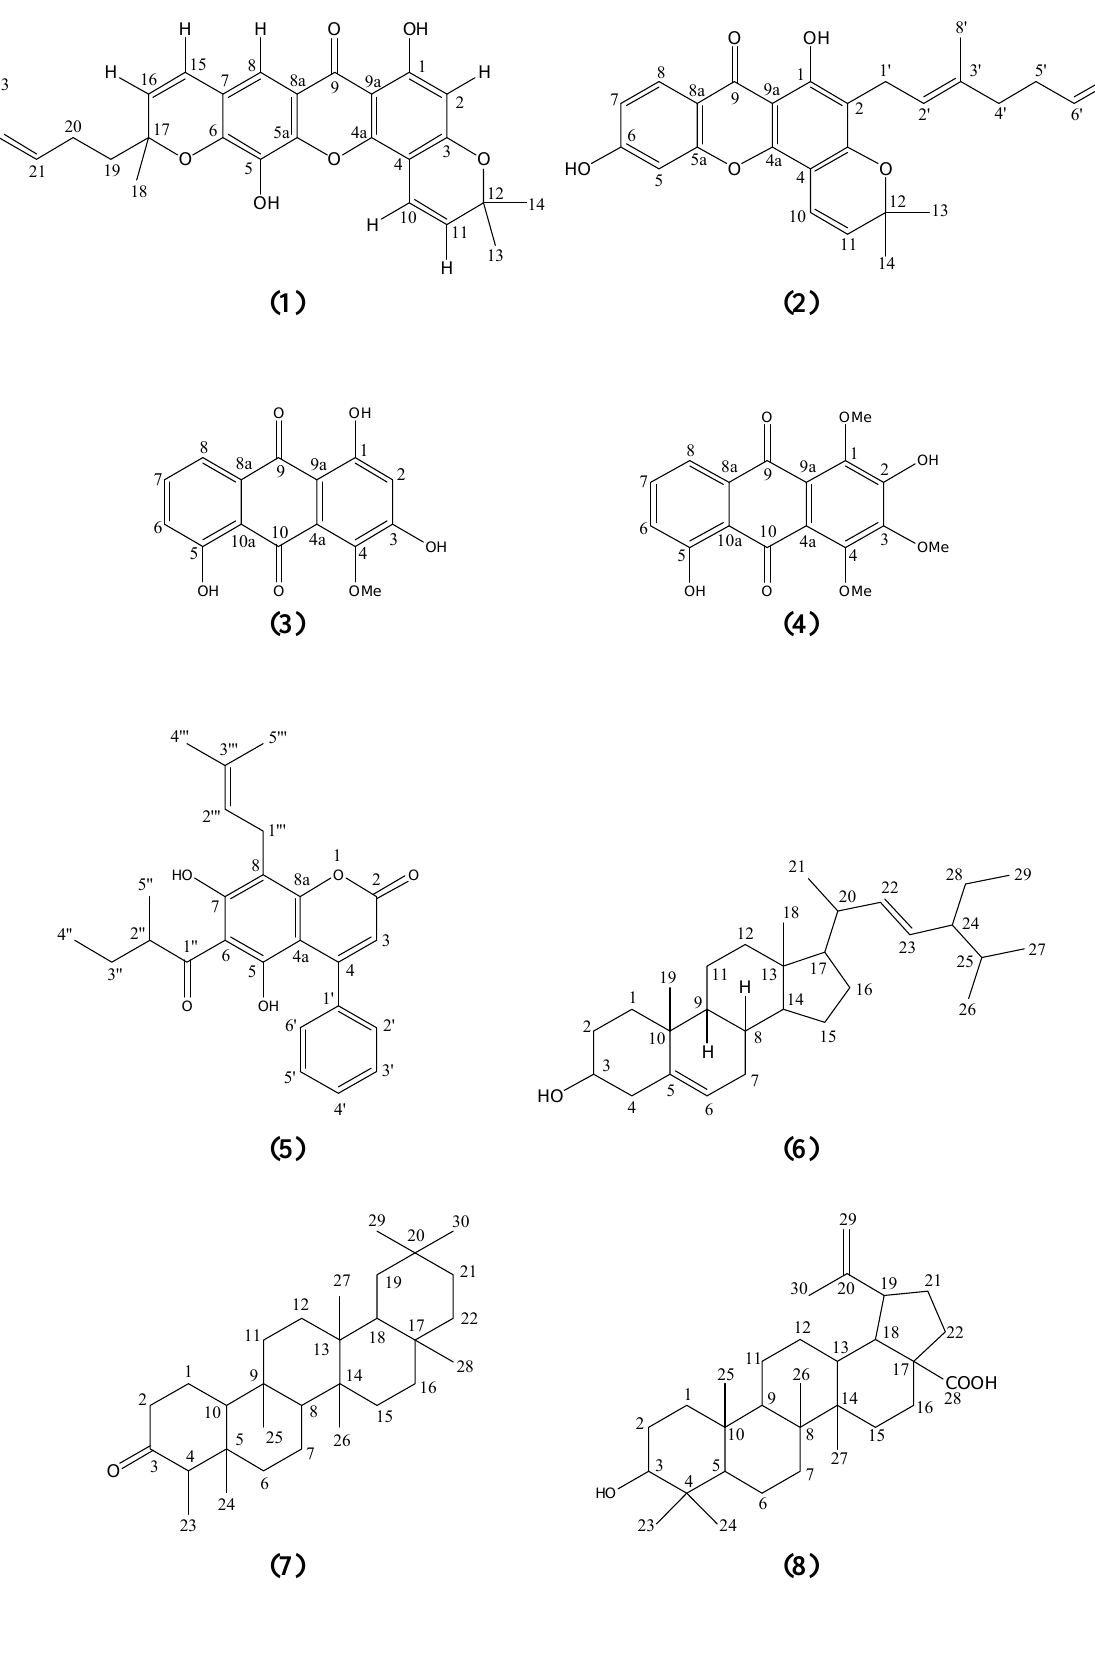
Figure 1. Structures of